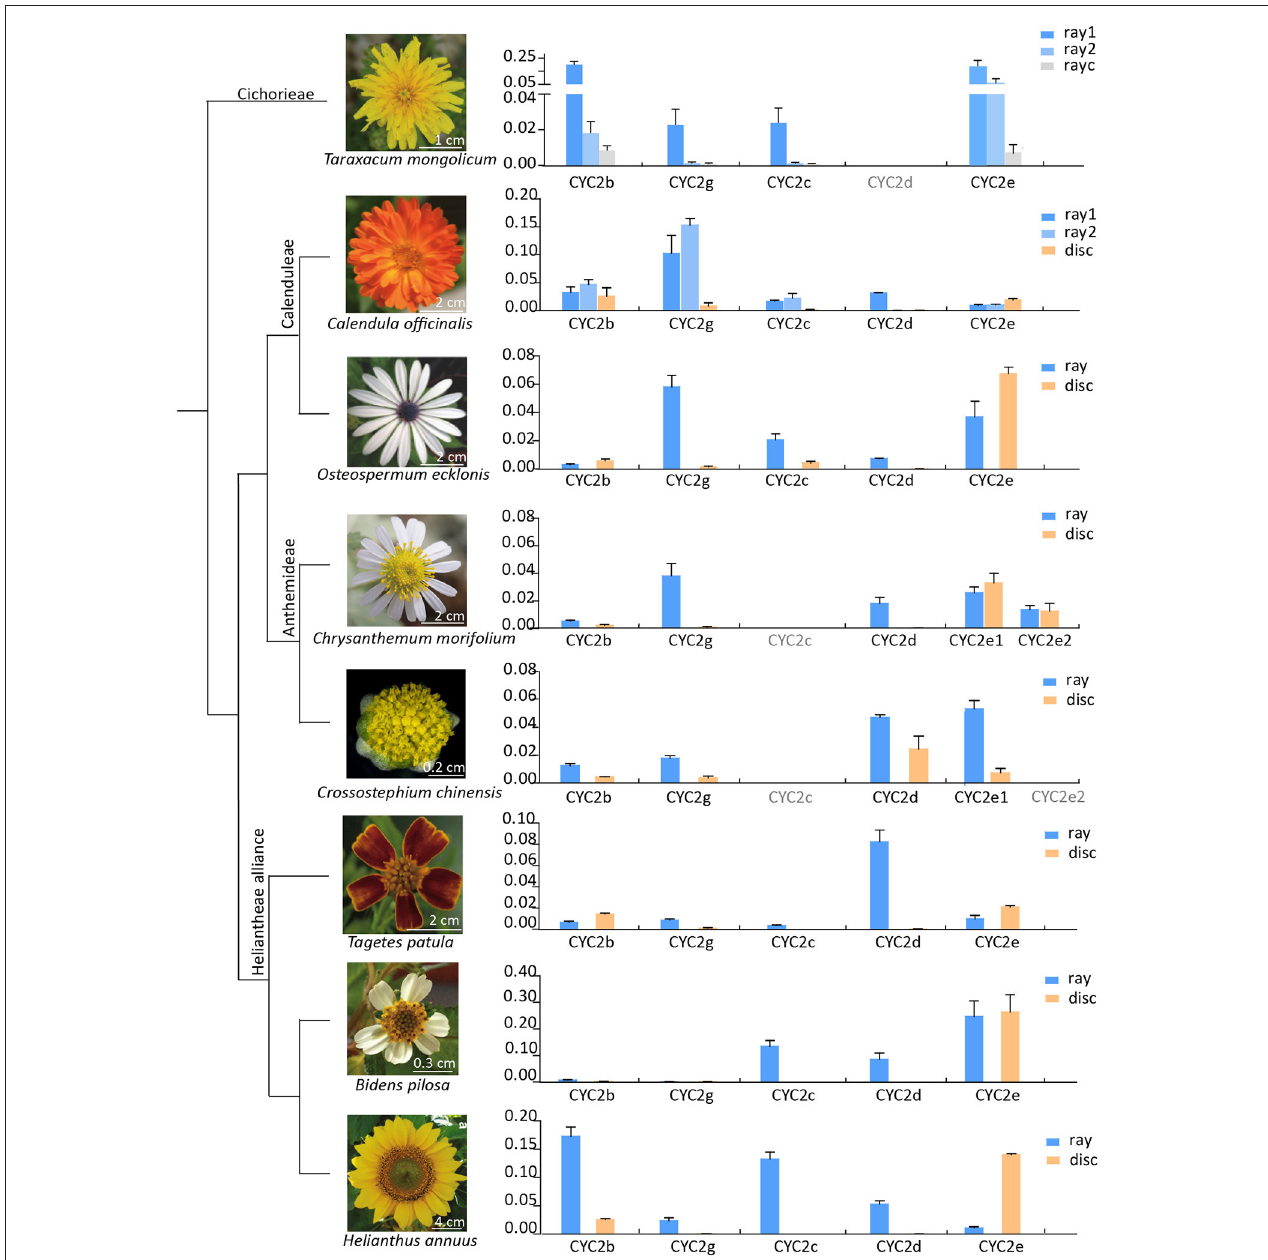
FIGURE 3 | Relative expression levels of the Asteraceae CYC2 -like genes except CYC2a in eight species that represent major lineages of the family (Panero and Funk, 2008) and major capitulum types (liguliflorous, radiate and disciform capitula). Genes with their names in gray was not found or lost in the species. Gene expression levels were normalized against expression levels of ACTIN7 . Error bar is s.e. value of three biological samples. “ray1” and “ray2” for Taraxacum ± mongolicum and Calendula officinalis mean the first and second whole of rays, and “rayc” for T. mongolicum means central rays.